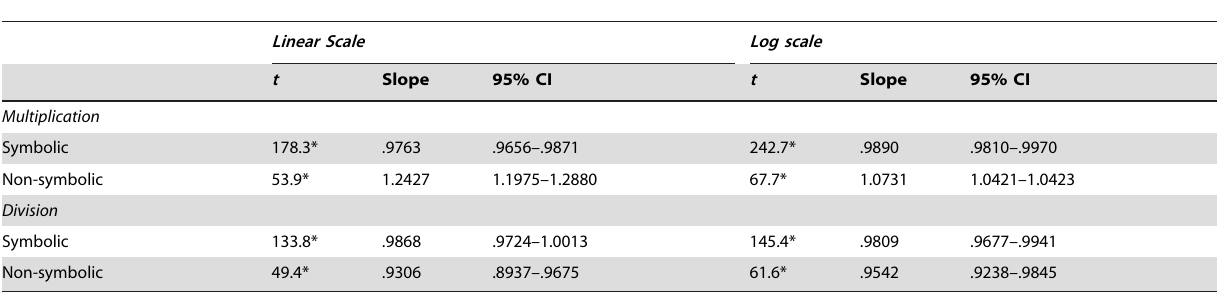
Table 3. Linear increase of response value with correct value.